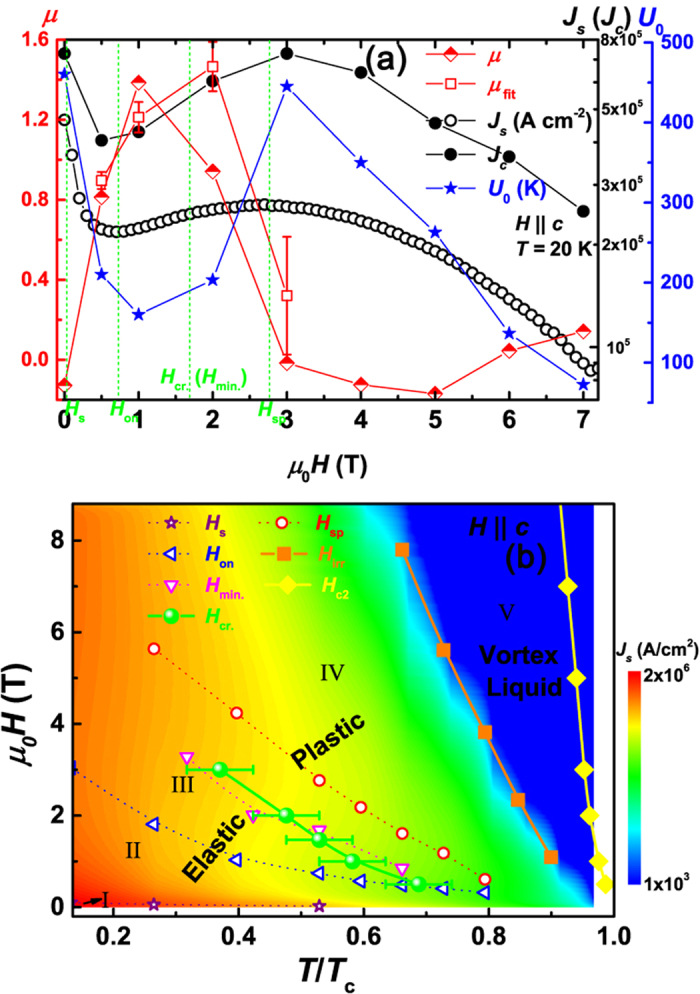
(a) Field dependence of critical current density Js (Jc), glassy exponent μ, and barrier energy U0. μ and U0 are directly obtained through Eq. (2) fitting of the original measured M(t > 50 s) data. Jc is calculated from Mc obtained in Eq. (2) fitting. μfit is obtained from the method in Fig. 4(c). The characteristic fields were also noted in the figure. (b) Vortex phase diagram of Ca0.8La0.2Fe0.978Co0.022As2 with various characteristic H(T). The color contour represents the critical current density Js as functions of temperature and field. Hc2 values are obtained from temperature-dependent resistivity curves under different magnetic fields using the criterion of 90% ρn (data shown in SI, Fig. S5). The irreversibility field Hirr is obtained by extrapolating Js to zero in the Js1/2 vs. H curves. The solid and dash lines are guide to the eye.